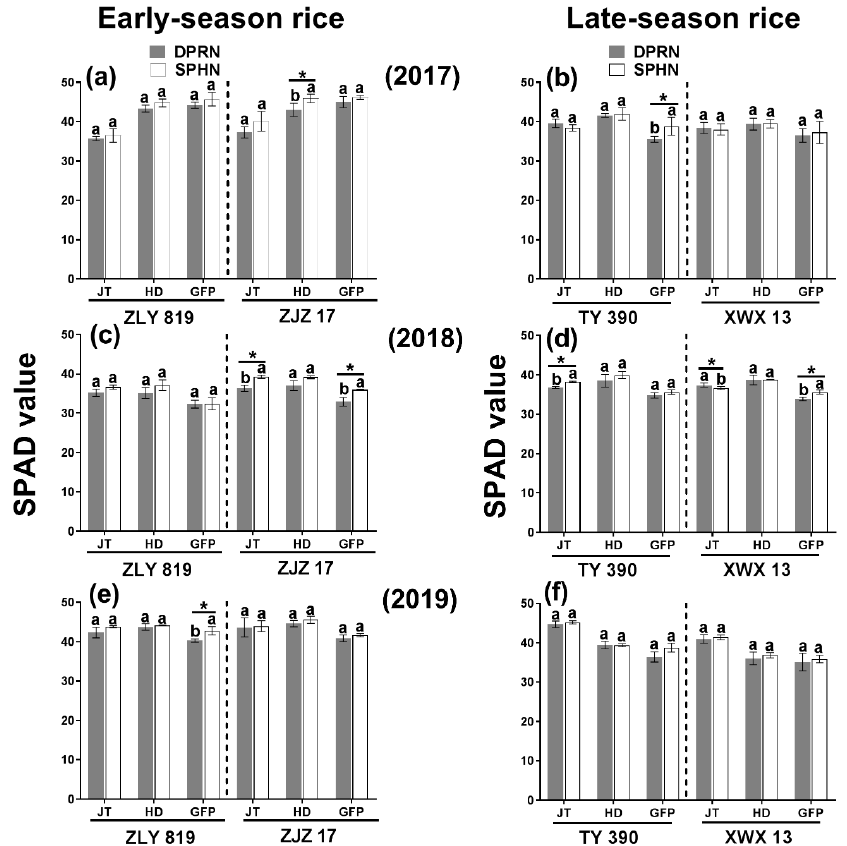
Figure 3. Chlorophyll content (SPAD) of double-cropped rice under different treatments from 2017 to 2019. Data points represent treatment means ( n = 3), and different letters indicate significant differences (* p < 0.05). DPRN represents dense planting with a reduced nitrogen rate; SPHN represents sparse planting with a high nitrogen rate. ZLY 819 (hybrid rice) and ZJZ17 (conventional rice) belong to early-season rice cultivars; TY 390 (hybrid rice) and XWX 13 (conventional rice) belong to late-season rice cultivars; ( a ) represents early − season rice in 2017; ( b ) represents late − season rice in 2017; ( c ) represents early − season rice in 2018; ( d ) represents late − season rice in 2018; ( e ) represents early − season rice in 2019; ( f ) represents late − season rice in 2019. Except that, the leaf area index of ESR ZLY819 in the heading stage under DPRN in